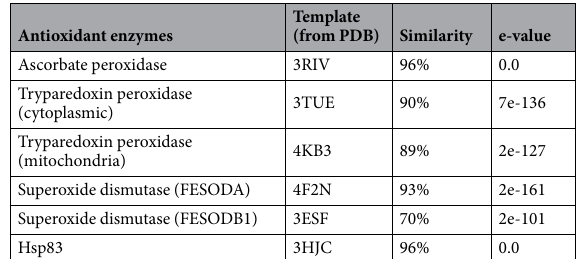
Antioxidant enzymes